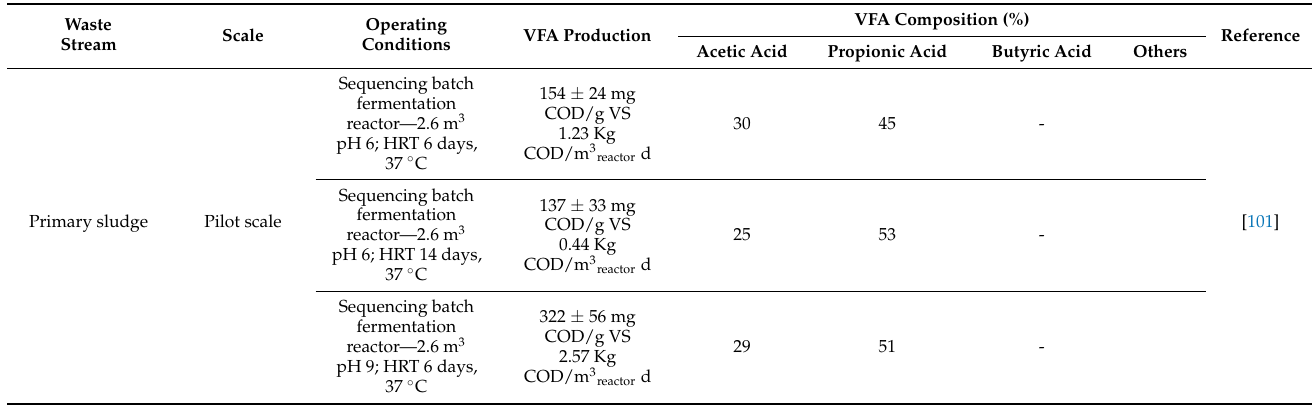
Table 9. VFAs produced at pilot- and